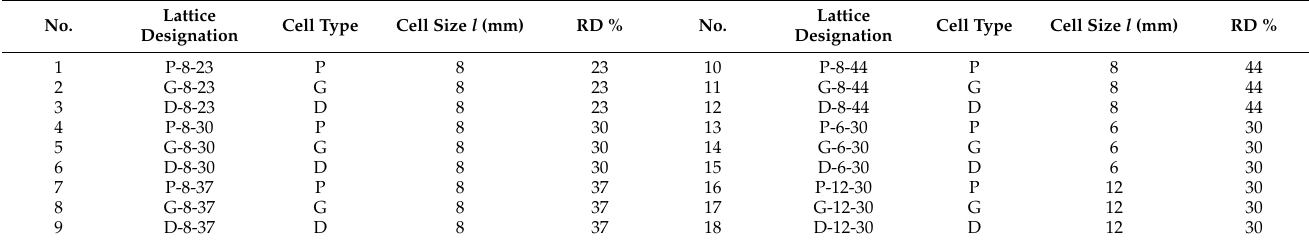
Table 3. Designed parameters of experimental tests.